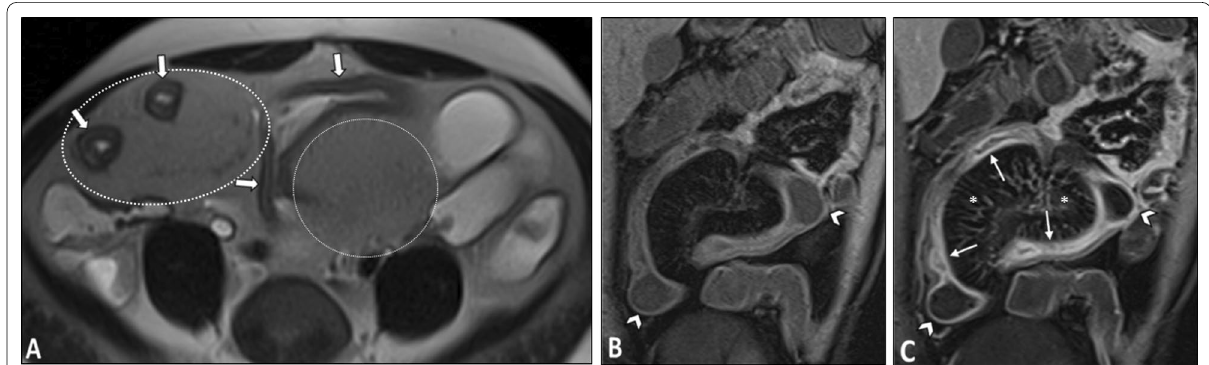
Fig. 21 Crohn’s disease in a 23-year-old male presenting with abdominal pain and transient obstructive episodes. MRE was obtained. Axial T2-W image ( A ) shows multi-focal mural thickening in several segments of the ileum (thick white arrows) associated with increased mesenteric fat (white dotted ovals) separating the bowel loops. Coronal pre- and post-contrast T1-W images ( B , C ) demonstrate increased striated mural enhancement of the affected bowel segments (thin white arrows), more predominant on the mesenteric border. Engorgement of mesenteric vessels is depicted (white asterisks) representing comb sign. There is also pseudodiverticula formation along the antimesenteric border (white